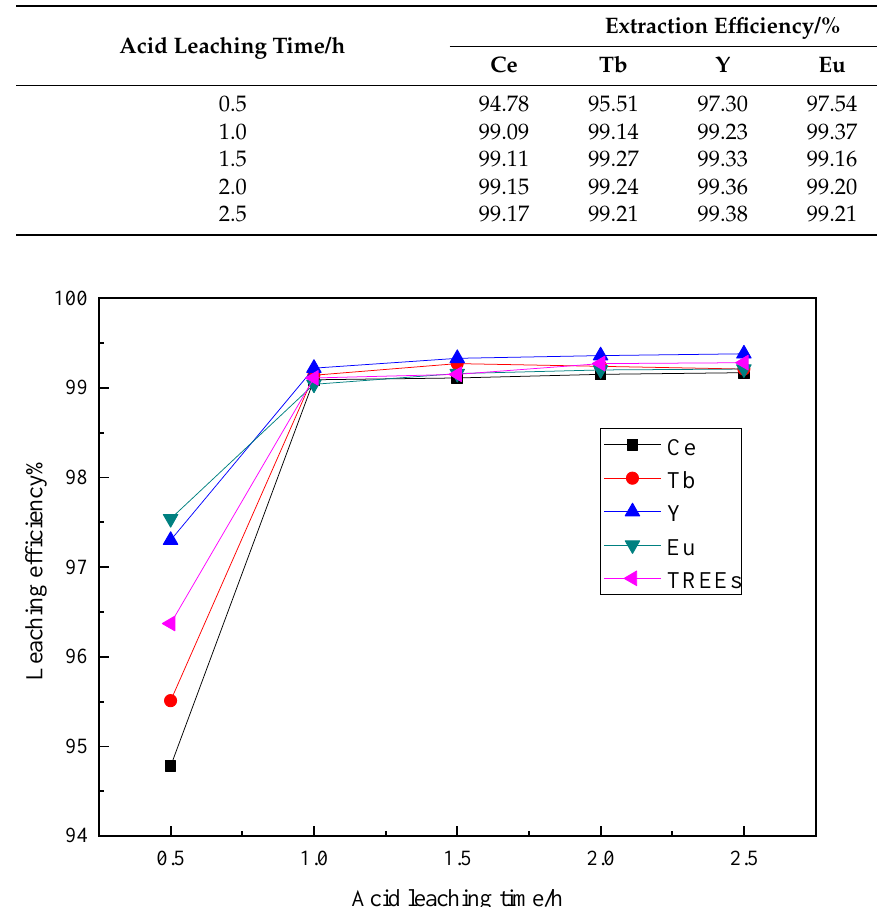
Figure 12. Influence of the acid leaching time on the REEs leaching efficiencies (oxygen concentration in the mixed gas of 0.4%, roasting temperature of 700 ◦ C, roasting time of 2.5 h, material ratio of phosphor powder to alkali 1:3, HCl solution concentration of 4 mol · L − 1 , acid leaching temperature of 60 °C, and liquid–solid ratio of 10:1).